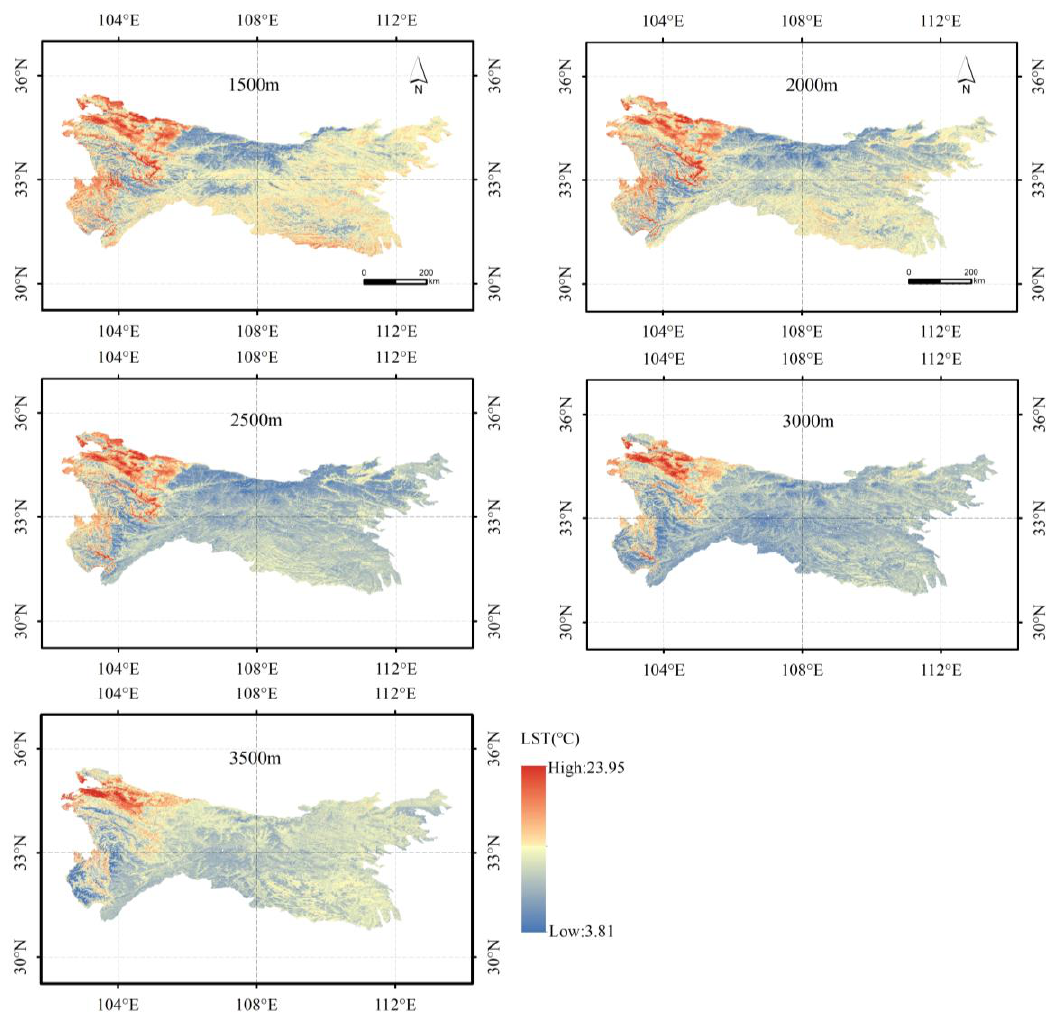
Figure 4. Spatial variation of LST at 1500 m, 2000 m, 2500 m, 3000 m and 3500 m in the Qinling – Daba mountains estimated using the random forest model. mountains estimated using the random forest model.